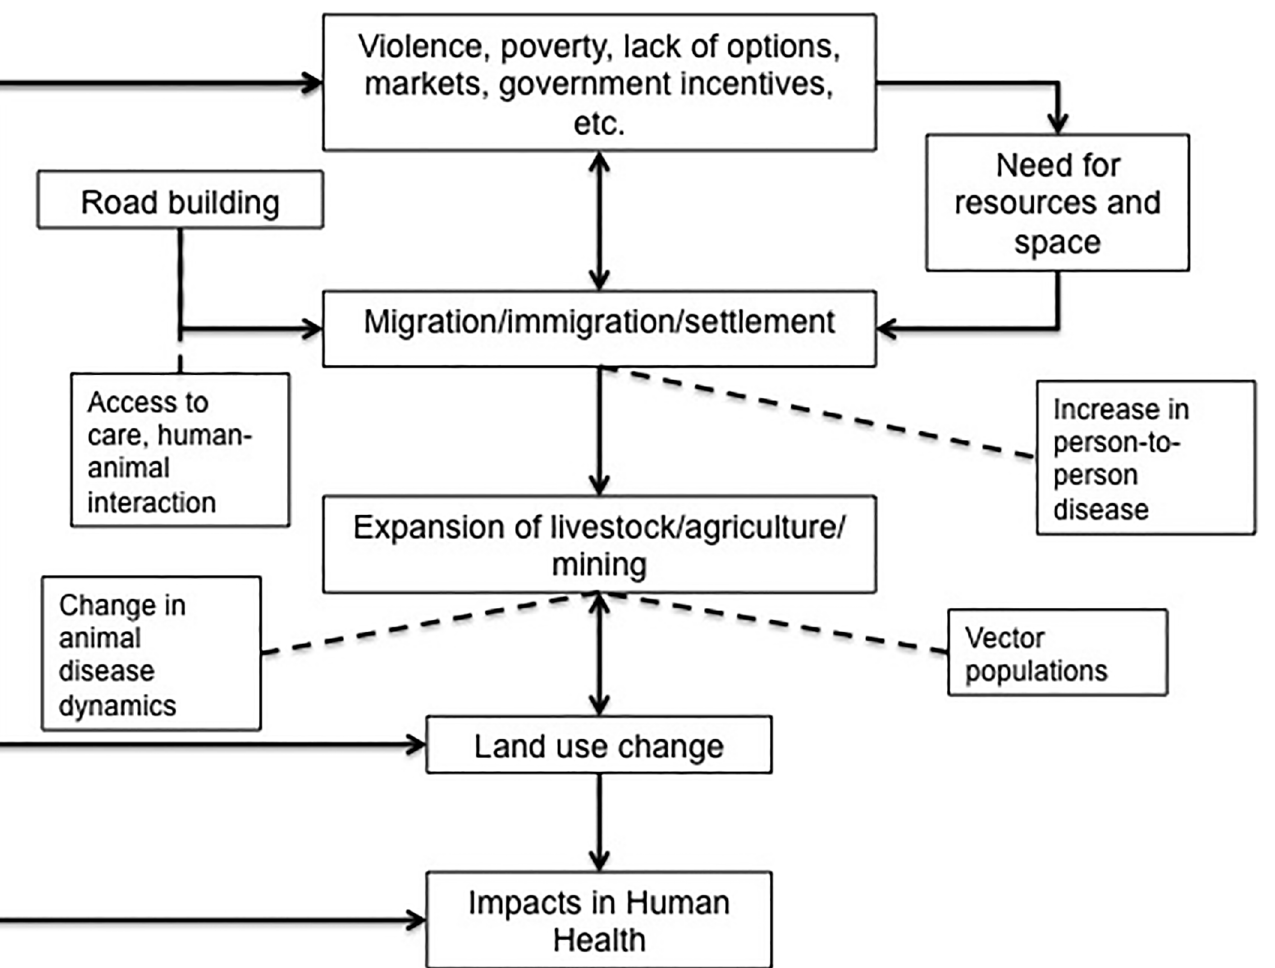
Fig 2. Factors relating to land use change. Conceptualization process for determining LUC and health topics.